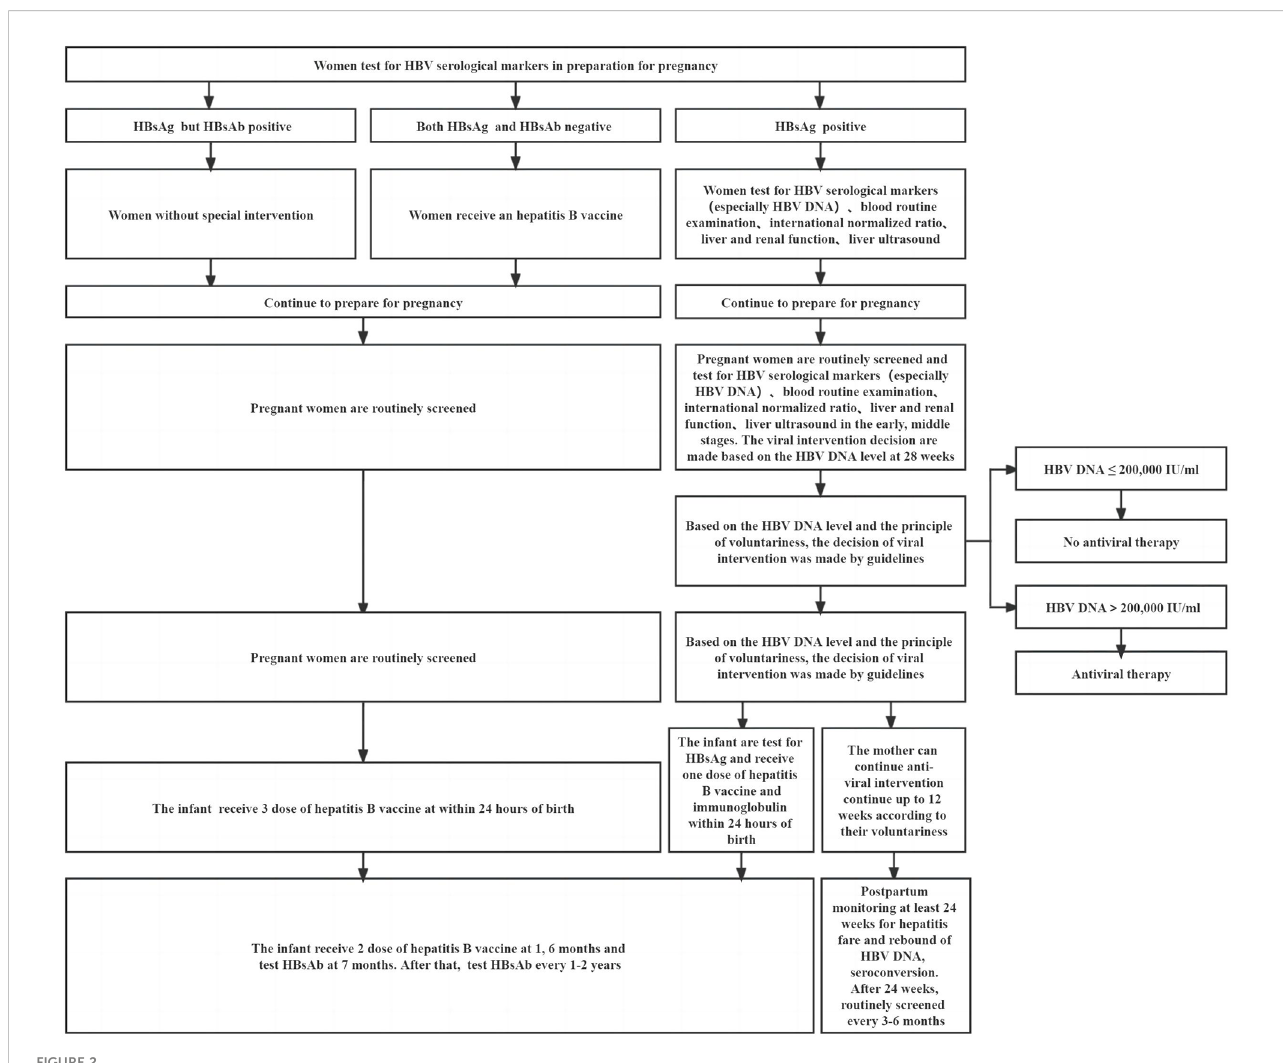
FIGURE 2 Recommendations for a woman of reproductive age during preparation for pregnancy, pregnancy, and